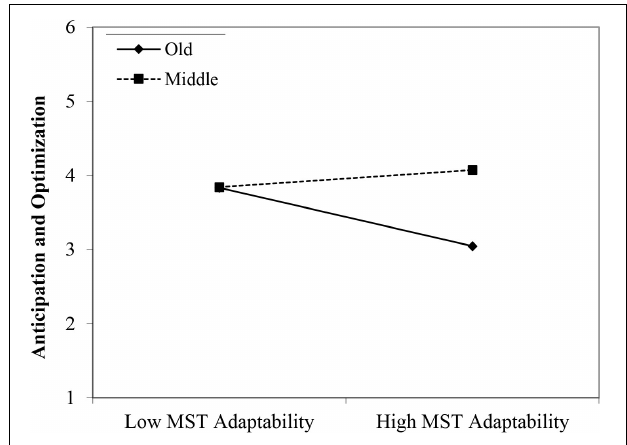
FIGURE 7 | Interaction between perceived age-based (meta-)stereotyping adaptability and age groups: Predicting anticipation and optimization.